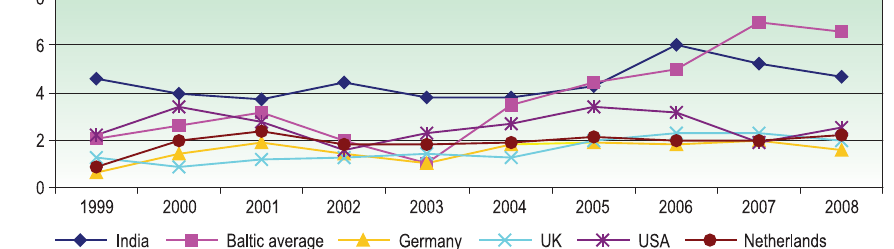
Fig. 1. Real GDP growth, percent Source: IMF statistics, 2007